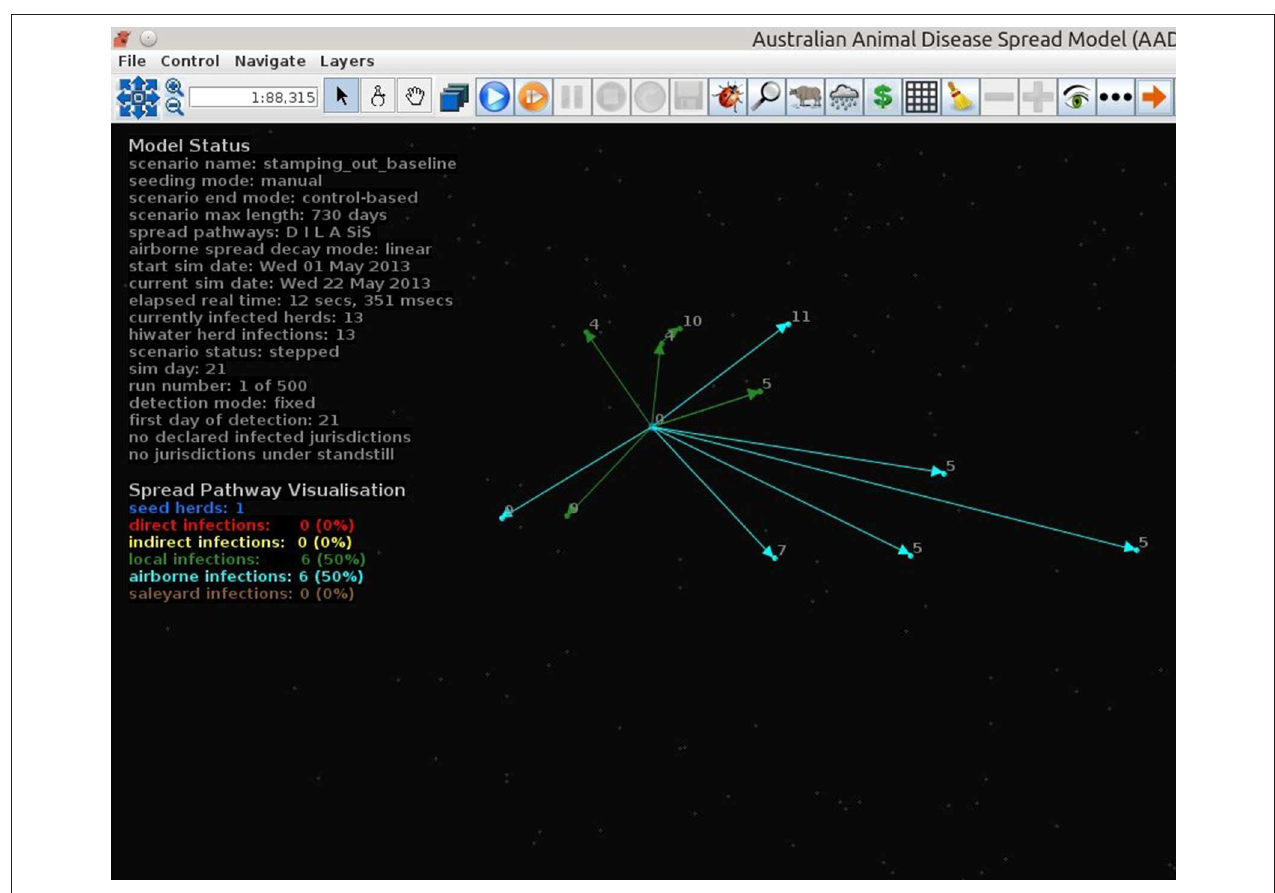
FIGURE 8 | Visualization of between-herd spread as an infection